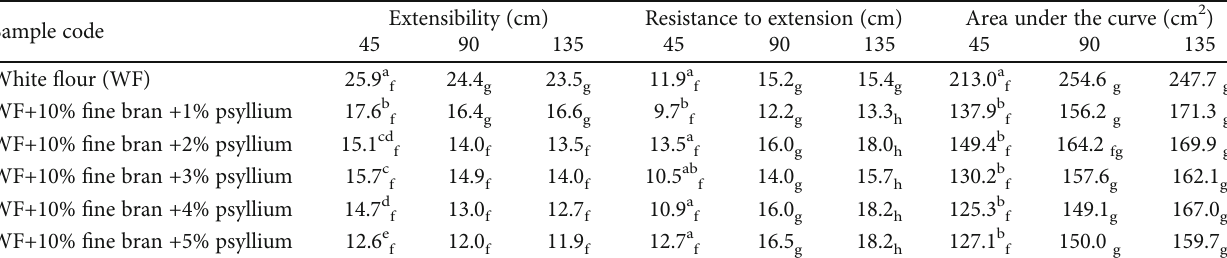
Table 9: Extensograph characteristics of dough made from fl our, fi ne bran, and psyllium blends. Sample